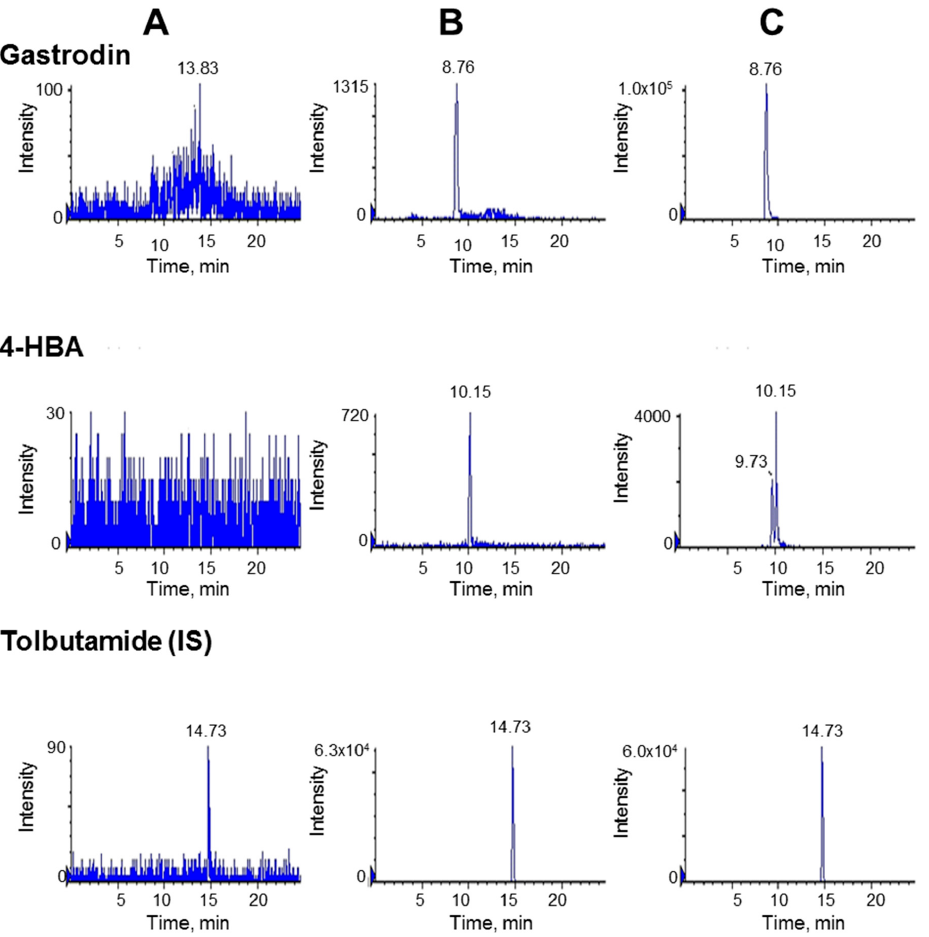
Figure 2. Representative liquid chromatography coupled to mass spectroscopy (LC-MS / MS) chromatograms of gastrodin, 4-HBA, and tolbutamide (IS). Left vertical panel ( A ), blank plasma samples; central vertical panel ( B ), blank plasma sample spiked with analyte at the lower limit of quantification (LLOQ); and right vertical panel ( C ), plasma sample obtained 30 min after oral administration with gastrodin at 40 mg /